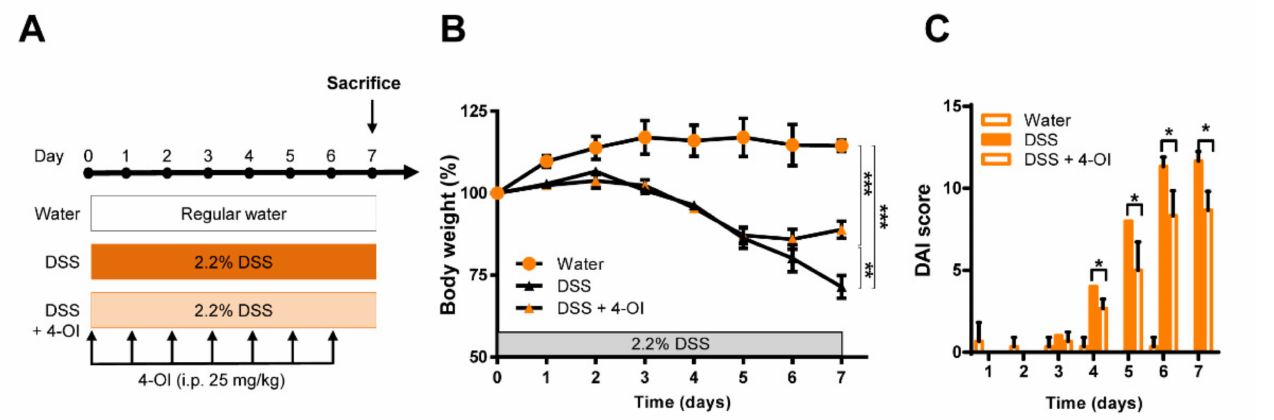
Figure 4. The effects of 4-octyl itaconate (4-OI) on DSS-induced colitis in acod1 − / − mice. ( A ) The experimental scheme for the administration of DSS and 4-OI. The 4-OI agent was injected intraperi- toneally daily at 25 mg/kg for 7 days. ( B ) The administration of 4-OI reduced the body weight loss caused by DSS-induced colitis in acod1 − / − mice. Symbols ** and *** denote p < 0.01 and p < 0.001, respectively. ( C ) The administration of 4-OI reduced the DAIs of mice with DSS-induced colitis. * p < 0.05 acod1 − / − mice (n = 6) + DSS versus acod1 − / − mice + DSS + 4-OI (n =